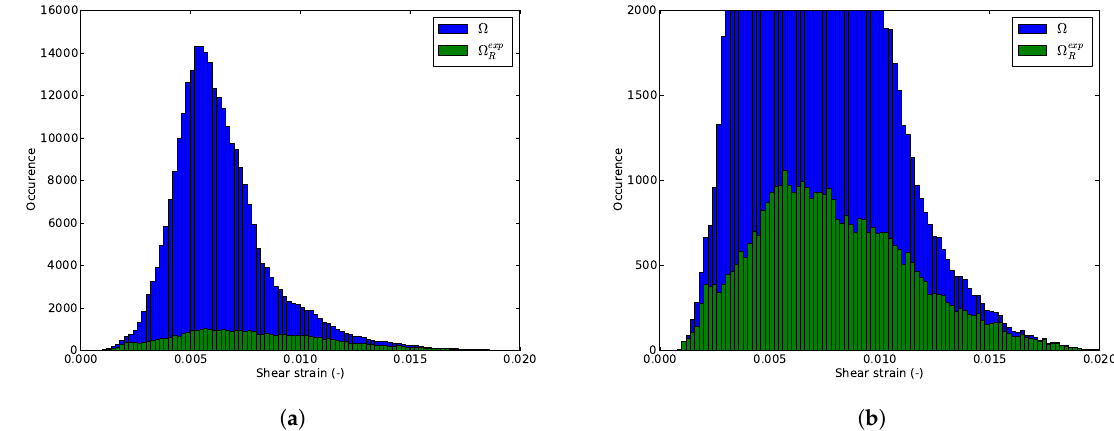
Figure 15. Shear strain distributions ( a ) in the whole domain and ( b ) in the RED at the last